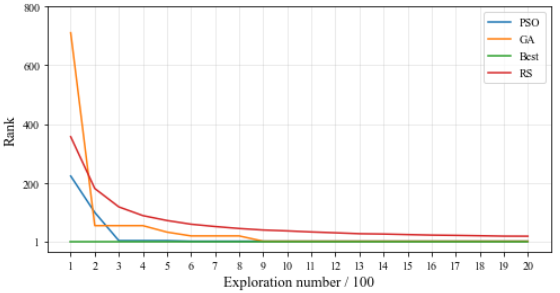
Figure 6. PMU placement ranking based on number of exploration: 33-bus system, N m = 4.